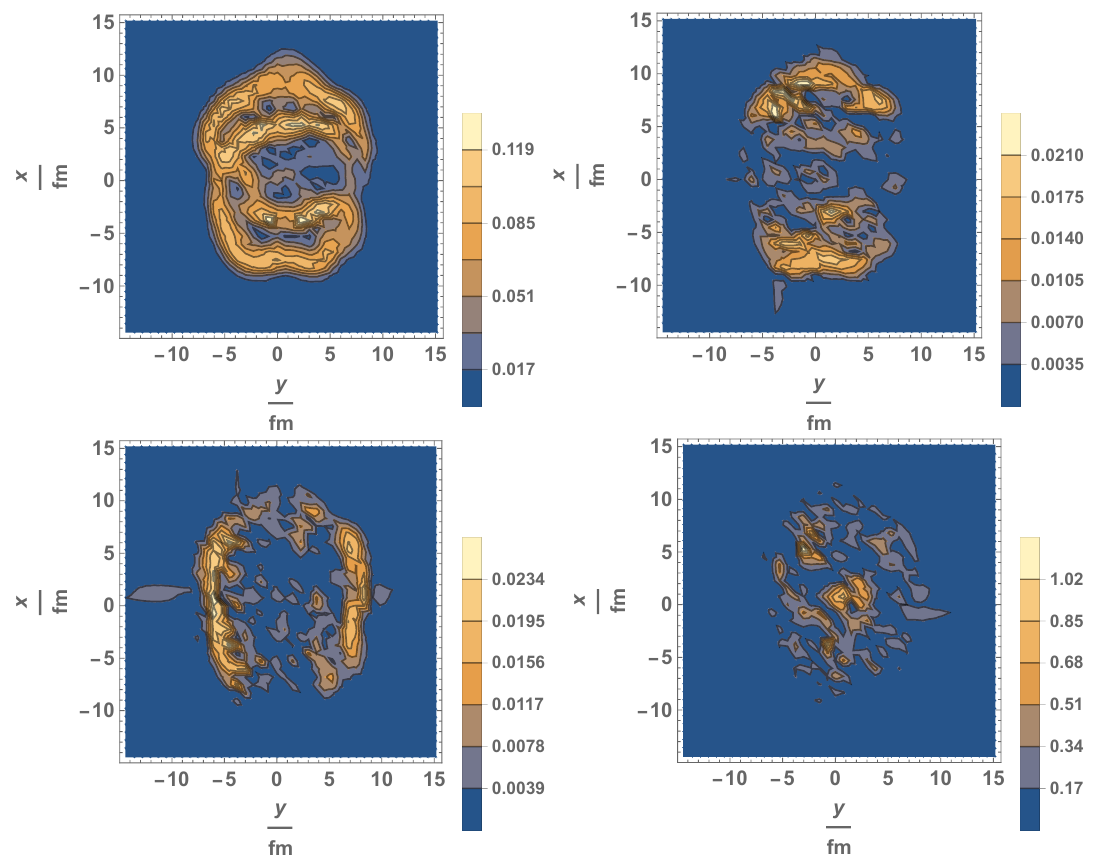
Figure 13 . Top left: the absolute value of the spatial components (¯ ω yz , ¯ ω xz , ¯ ω xy ) of the thermal vorticity ¯ ω µν , on the central plane z = 0 . Top right: the absolute value of ¯ ω tx . Bottom left: the absolute value of ¯ ω ty . Bottom right: the absolute value of ¯ ω tz (= − ¯ ω zt ) , which is the only non-negligible component of the thermal vorticity at the center of the hydrodynamized part of the plasma. All plots display results at t = 0 . 1 fm/ c and are given in units of